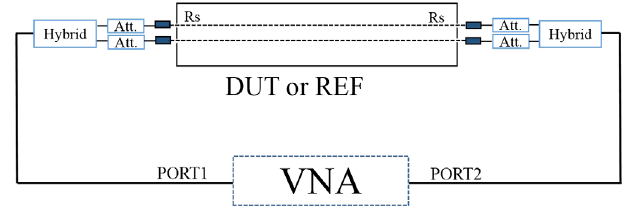
FIG. 14. Schematic view of transverse impedance measurement.